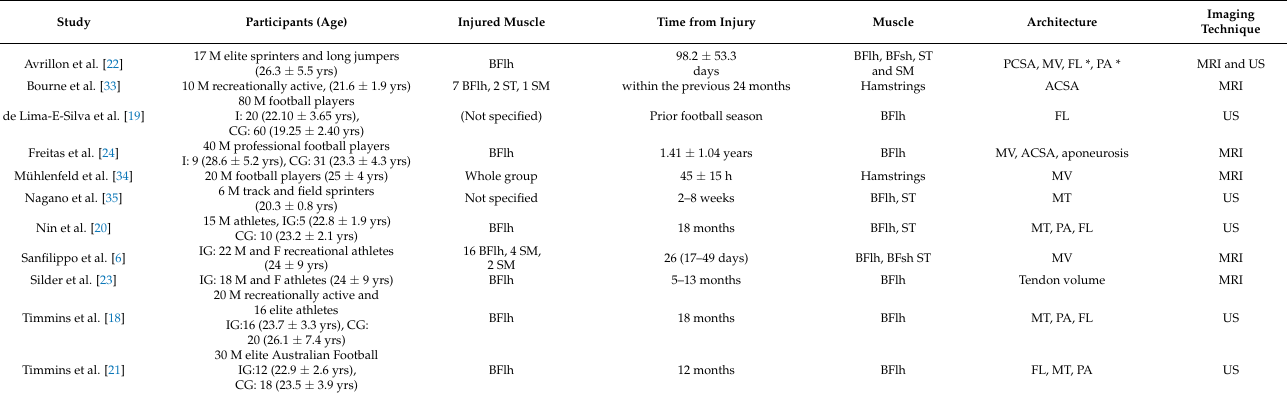
Table 2. General characteristics of the included